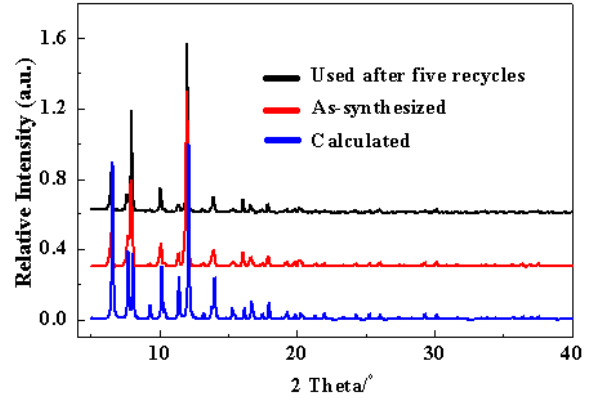
Figure 1. X-ray diffraction patterns for Cu-TDPAT samples, as-synthesized ( red ); and used after five catalysis cycles ( black ).